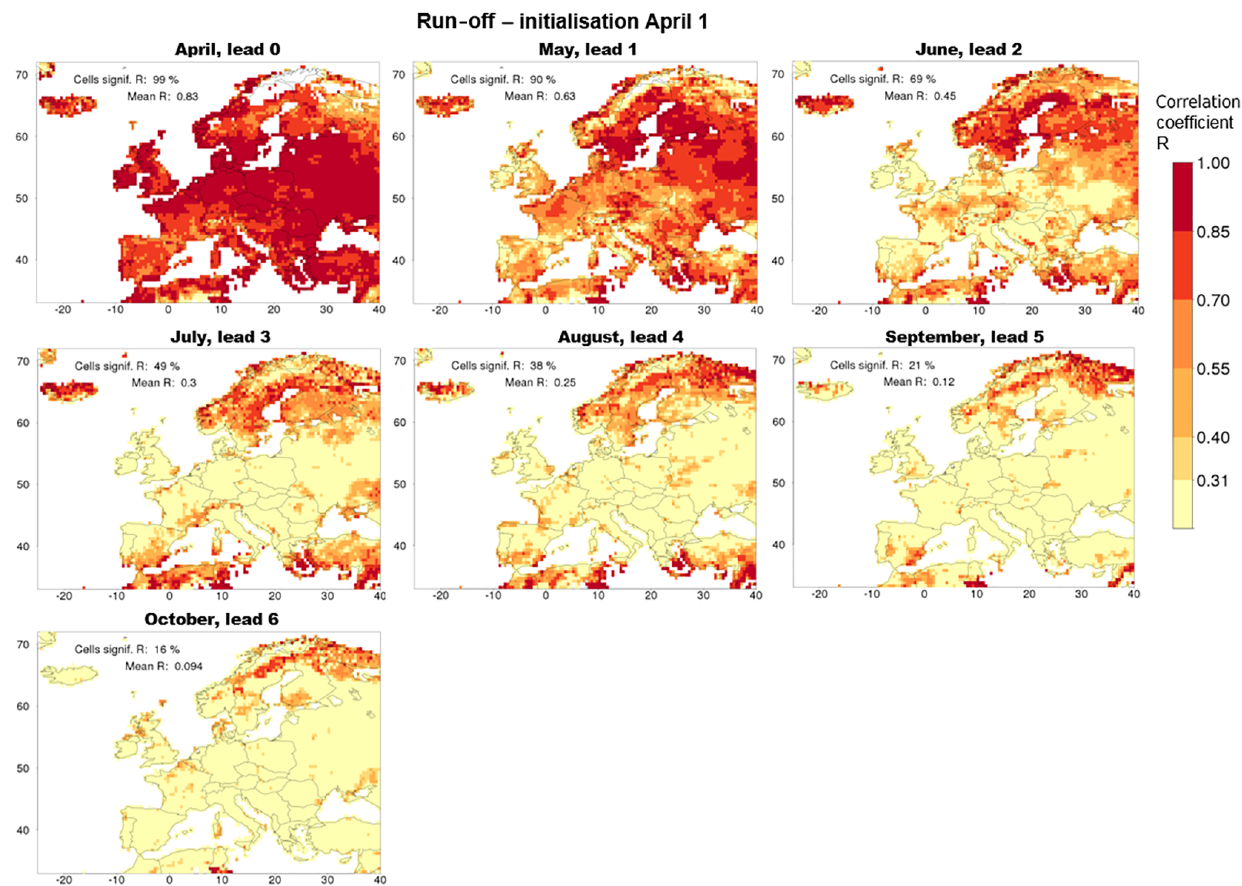
Figure 2. The skill of the run-off hindcasts initialised on 1 April for all 7 lead months. The skill is measured in terms of the Pearson correlation coefficient between the median of the hindcasts and the observations ( R ). The threshold of significant skill lies at 0.31, so yellow cells have insignificant skill while darker cells have significant skill. White, terrestrial cells correspond to cells where observations or hindcasts consist of more than one-third zeros or one-sixth ties. The legend provides the fraction of cells with significant values of R (at the 5% level) and the domain-averaged value of R